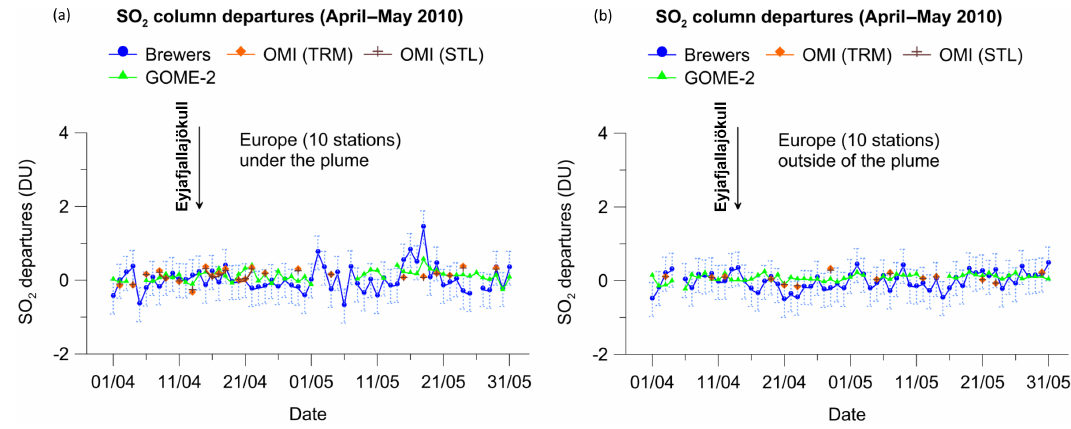
Figure 12. Mean SO 2 column departures from the unperturbed 10-day pre-volcanic baseline measured by Brewers, OMI (TRM, STL) and GOME-2 during April–May 2010 over Europe following the 2010 Eyjafjallajökull volcanic eruption for (a) stations under the volcanic SO 2 plume and (b) stations outside of the plume. The error bars for the Brewer observations show the standard deviation of all daily values during the unperturbed 10-day period prior to the volcanic eruption. Brewer stations under the plume are Sodankylä, Obninsk, Manchester, De Bilt, Uccle, Belsk, Reading, Hohenpeißenberg, Davos and Arosa. Stations outside of the plume are Vindeln, Oslo, Norrköping, Copenhagen, Hradec Králové, Aosta, Kislovodsk, Rome, Thessaloniki and Athens. Each daily average from either OMI or GOME-2 was calculated if and only if more than half of the individual overpasses had data on a given day. The arrow marks the starting date of the eruption (beginning on 14 April until 24 May